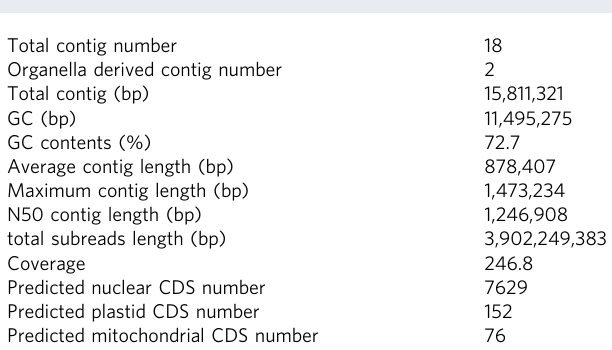
Table 1 Basic data for the Medakamo hakoo